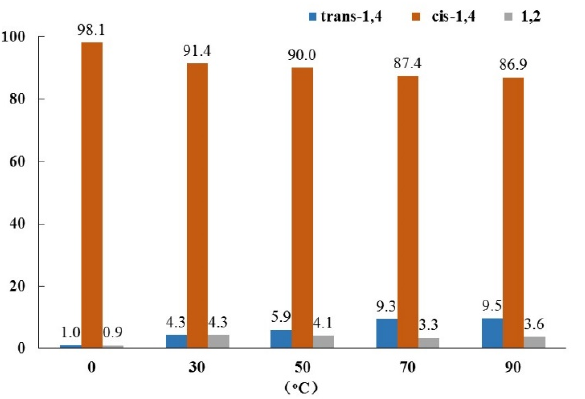
Figure 4. The microstructures of the polybutadiene obtained at different temperatures with Co4 .